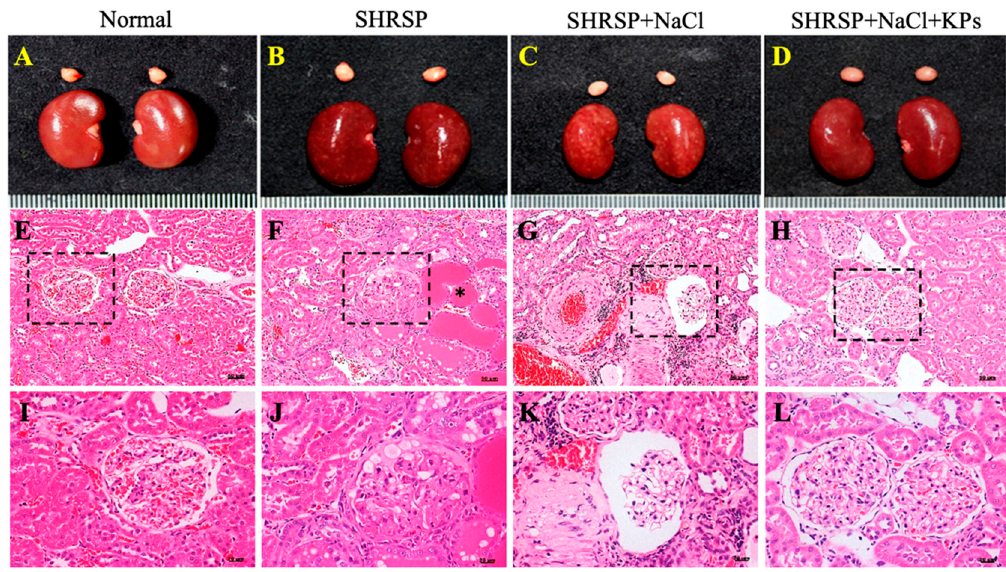
Figure 1. Exterior views of the kidneys of Wistar-Kyoto (WKY) and salt-induced SHRSP rats with or without kefir peptides (KPs) treatment and histopathological findings. The kidney exterior in normal WKY rats was smooth, plump, and reddish-brown ( A ). Kidneys with congestion, focal and firm lesions, and a coarse, irregular surface were observed in the untreated SHRSP rats ( B ), and the damage was even more severe in the kidneys of salt-treated SHRSP rats ( C ), but fewer or no gross lesions were observed in the salt-treated SHRSP rats administered KPs ( D ). As shown by hematoxylin and eosin (H&E) staining followed histopathological examination, ( E ) and ( I ) show normal kidney structures under 200 × and 400 × magnification, respectively. ( F ) and ( J ) show heterogeneous components of the glomeruli with some degenerative vacuole changes, hyaline cast formation (*), and moderate arteriolar hypertrophy in the juxtamedullary cortex with chronic progressive nephrosis under 200 × and 400 × magnification, respectively. ( G ) and ( K ) show tubular atrophy, tubular dilation, casts, hyperplasia, interstitial fibrosis, glomerulosclerosis, glomerular atrophy, interstitial inflammatory infiltrates, the Bowman’s space, and severe arterial wall thickening in the juxtamedullary cortex with chronic progressive nephrosis under 200 × and 400 × magnification, respectively. ( H ) and ( L ) show mild symptoms of chronic nephrosis. ( E – L ) Three fields were imaged for each individual. Table 2. Summary of the pathological scores related to kidney disease in different treatment groups of SHRSP rats.